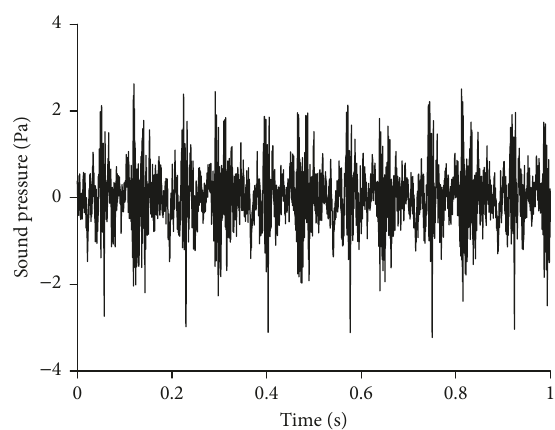
Figure 11: Time-domain map of the noise